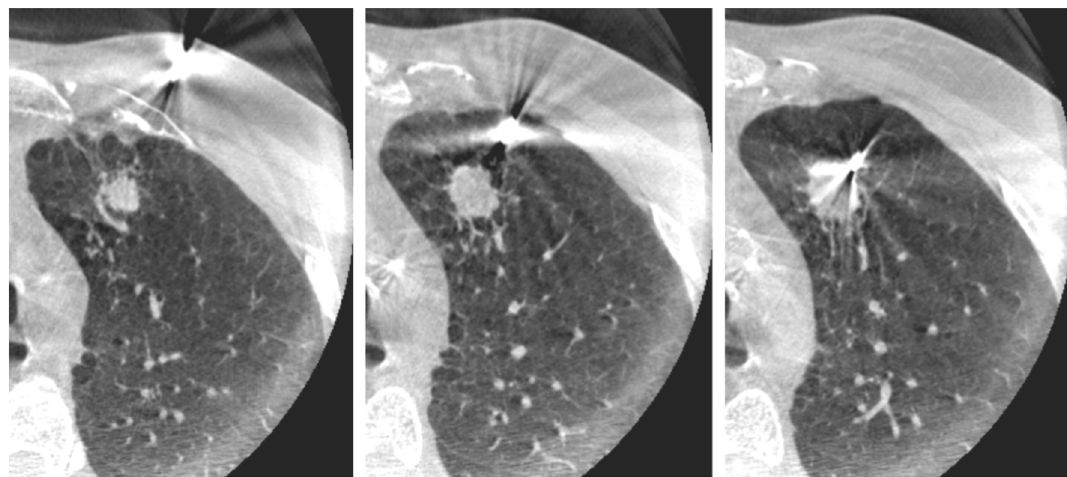
Fig. 5 Progressive images of Cone-beam-guided chest biopsy of a pulmonary nodule in the left upper